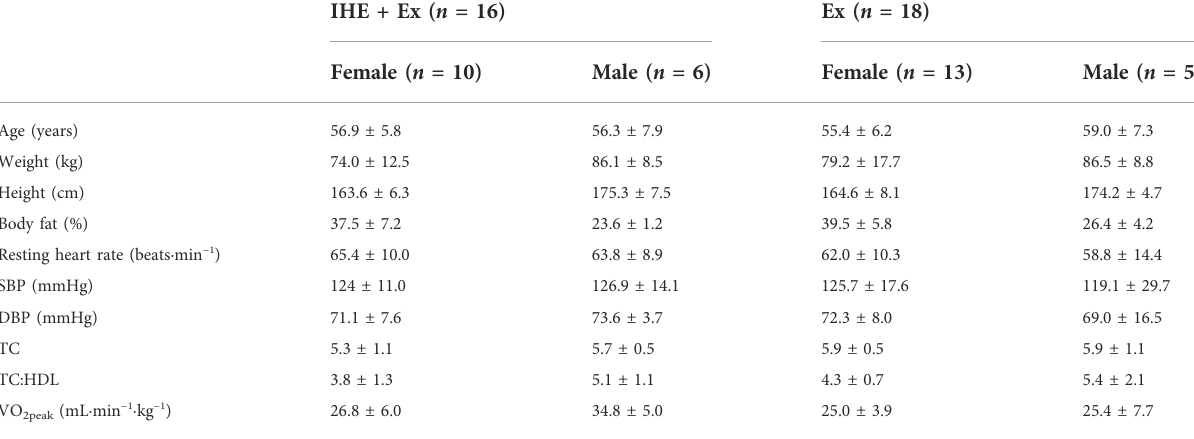
TABLE 1 Participant ’ s baseline